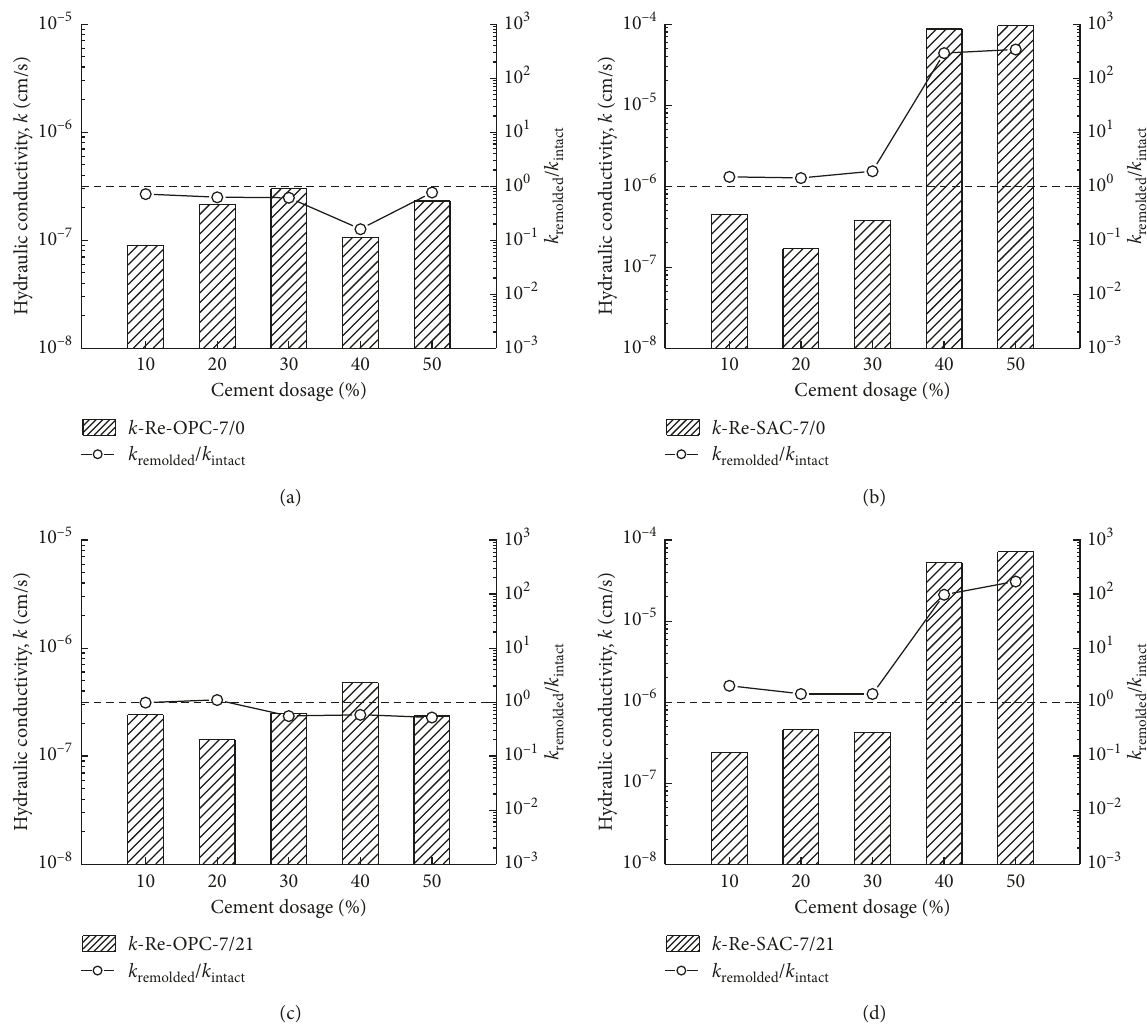
Figure 3: Effect of remolding on k of solidified sludge: (a) OPC-7/0; (b) SAC-7/0; (c) OPC-7/21; (d) SAC-7/21. Note: XXX-( i )/( j ) indicates that the curing time of XXX-solidified sludge before and after remolding is ( i ) days and ( j ) days,